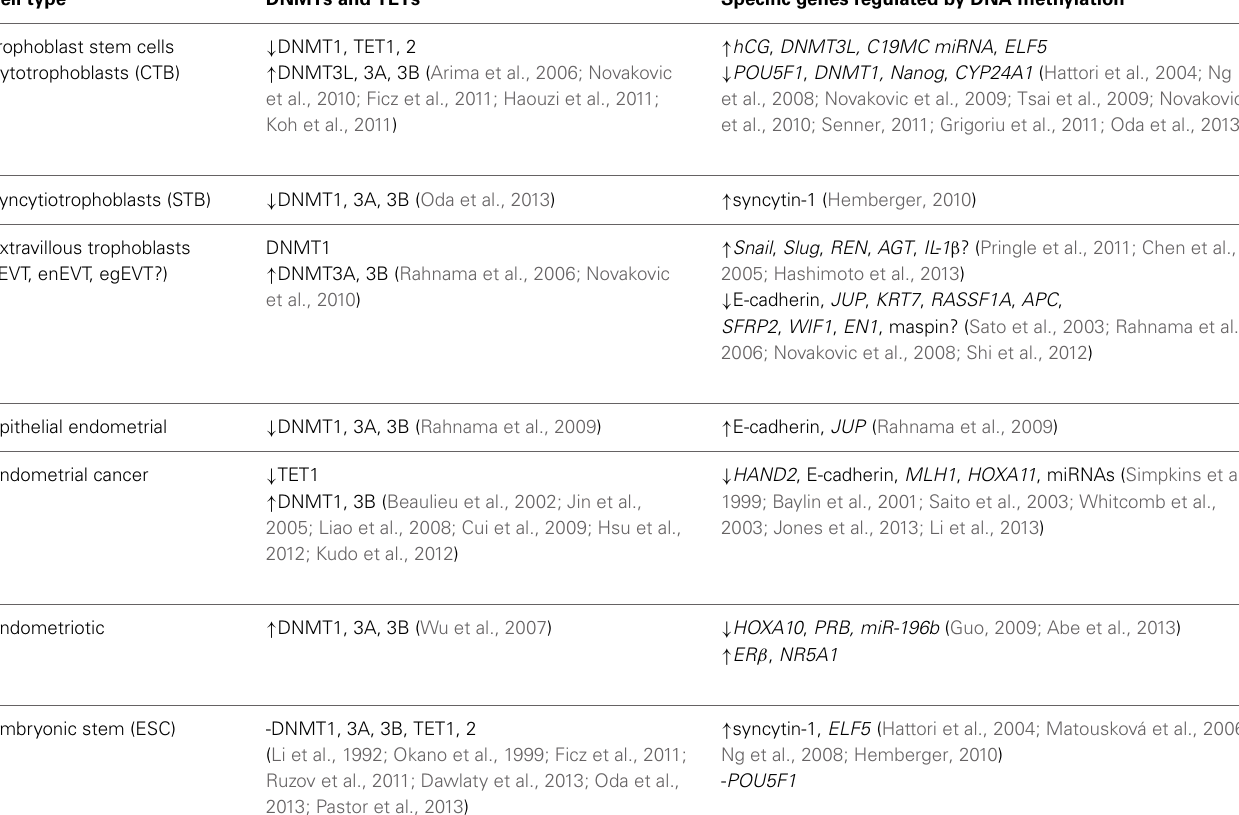
Table 1 | DNA methyltransferases (DNMTs) and TETs regulate specific key genes for differentiation and